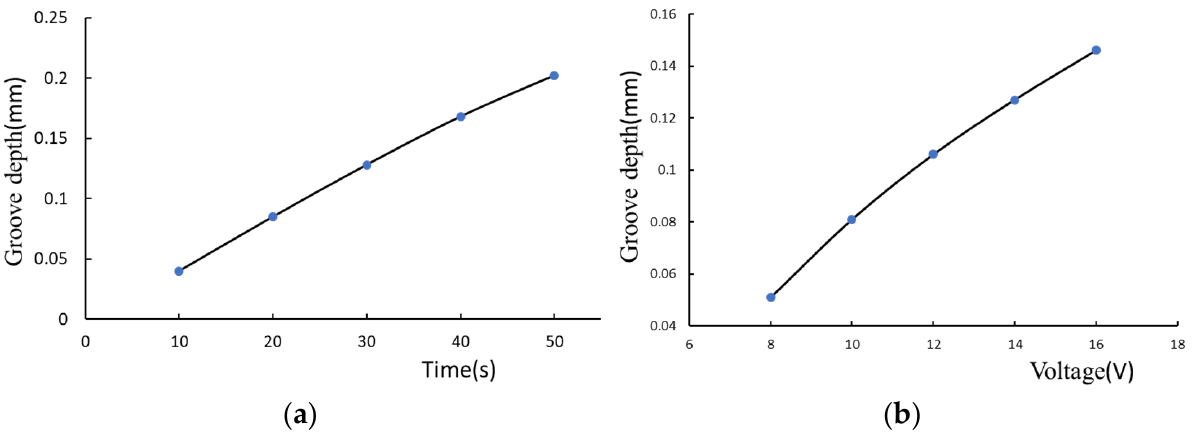
Figure 8. Slot depth variation diagram. ( a ) The relationship between the depth of the slot and the